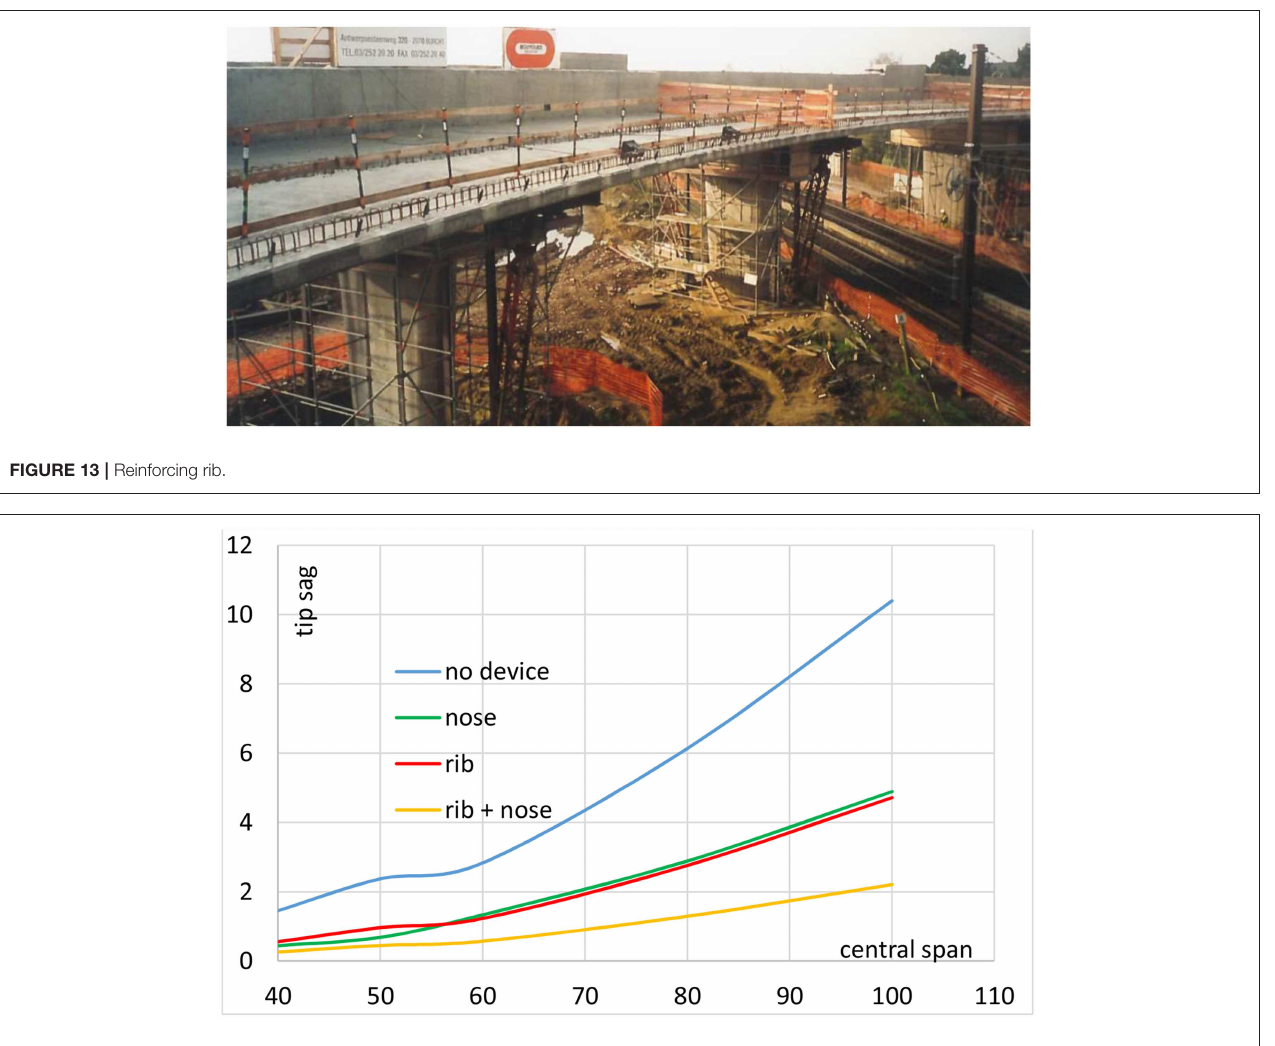
FIGURE 14 | Tip deflections during